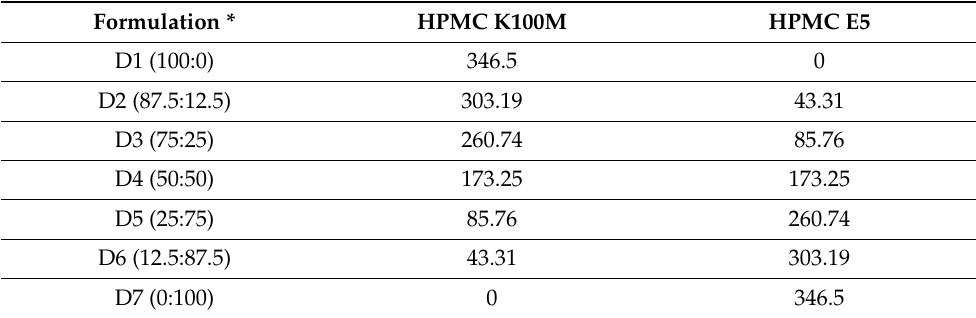
Table 16. The formulations of D1 to D7.